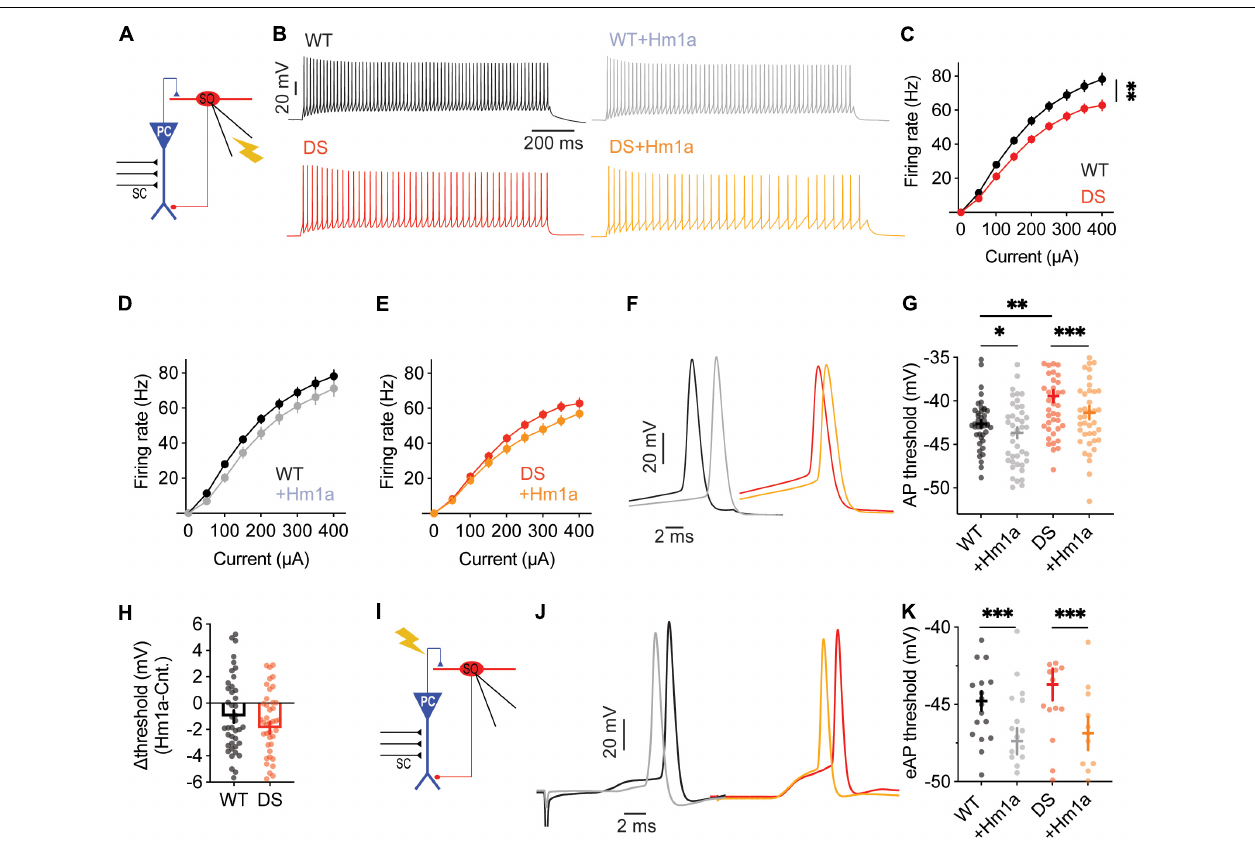
FIGURE 1 | Stratum-oriens interneurons from WT and DS Scn1a A1783V / WT mice respond similarly to Hm1a. (A) Illustration of the recording configuration. Firing properties of SO interneurons (red) were measured in response to current injection through the patch pipette (B–H) . (B) Representative traces of whole-cell current clamp recordings from WT and DS SO interneurons in response to current injection of +150 pA, before and after Hm1a application. (C) Firing frequency in response to depolarizing current injection at the indicated intensities in WT and DS. Statistical analysis utilized Mixed Model Repeated Measures ANOVA. (D,E) The effect of Hm1a on firing frequencies, in response to current injection through the whole-cell patch electrode in WT (D) and DS (E) mice. Statistical analysis utilized Two Way Repeated Measures ANOVA; (D) p = 0.36 for Hm1a treatment, p = 0.96 for current × treatment; (E) p = 0.37 for Hm1a treatment, p = 0.44 for current × treatment. (F) Representative WT and DS APs at rheobase, before and after Hm1a application. (G) The effect of Hm1a on AP threshold at rheobase current. Statistical analysis utilized Two Way Repeated Measures ANOVA. The markings on the graph depict the results of Bonferroni post hoc analysis: p = 0.001 ( ∗∗ ) for genotype; p < 0.001 ( ∗∗∗ ) for Hm1a treatment; p = 0.23 for the interaction. (H) The difference in AP threshold. The data in (C–H) included WT: n = 42 cells from 17 mice; DS: n = 43 cells from 14 mice. (I) Illustration of the recording configuration. Synaptic activation of SO interneurons (red) was triggered by antidromic activation of CA1 pyramidal neurons via stimulation of the alveus. (J) Representative traces of eAPs before and after Hm1a application. (K) The difference in eAP threshold. Statistical analysis utilized Two Way Repeated Measures ANOVA. The markings on the graph depict the results of Bonferroni post hoc analysis: p = 0.18 for genotype; p < 0.001 ( ∗∗∗ ) for Hm1a treatment; p = 0.28 for the interaction. WT: n = 18 cells from 5 mice; DS: n = 15 cells from 4